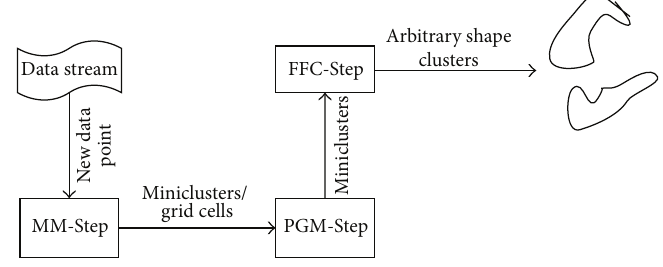
Figure 2: Overall view of HDC-Stream algorithm.